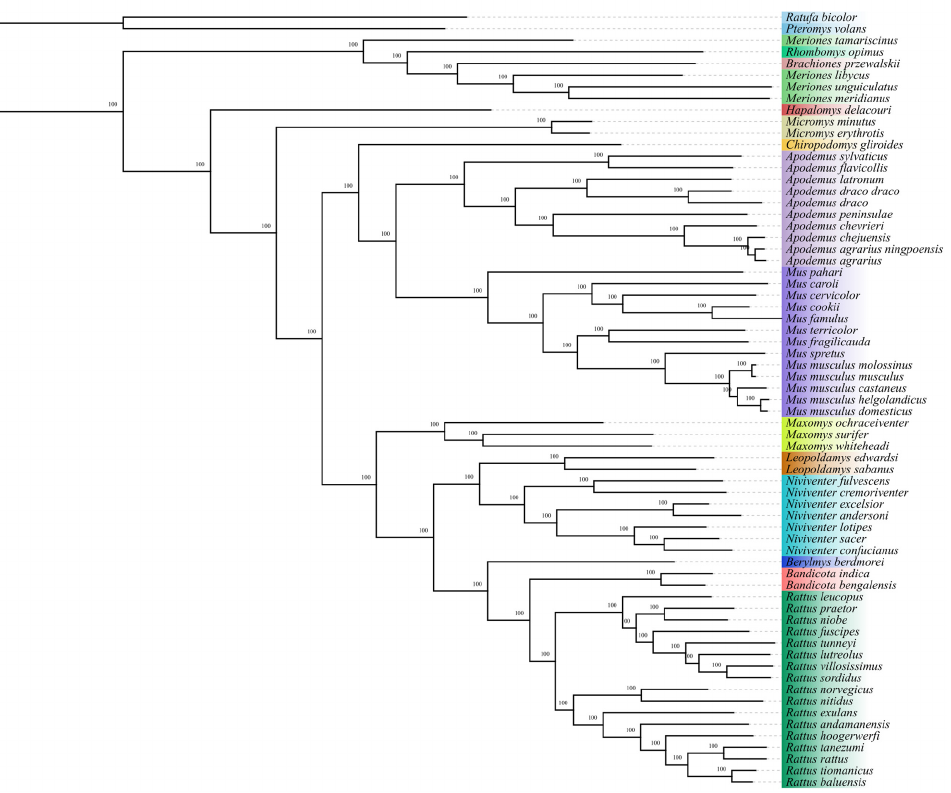
Figure 9. Phylogenetic tree inferred from mitochondrial genome sequences using BI. Bootstrap support values are indicated on branches. Different genera are distinguished by different colors.